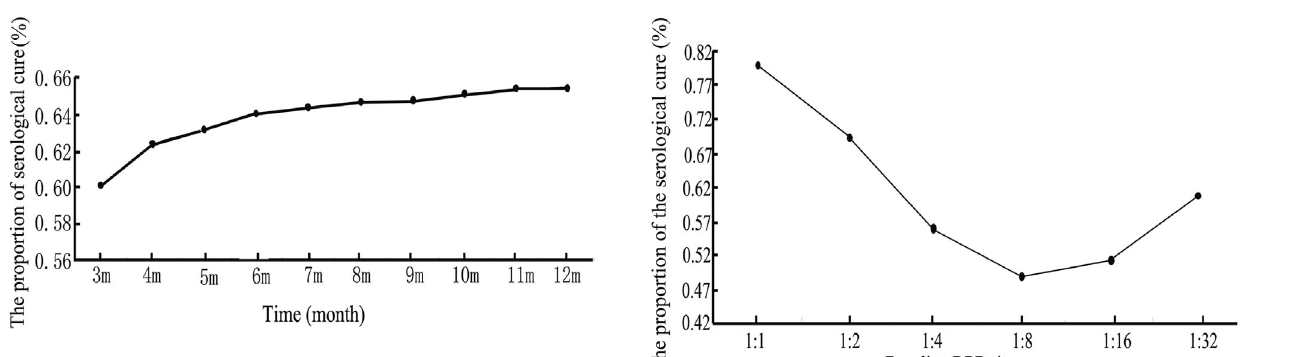
Figure 2. The proportion of the serological cure over time from 3 to 12 months. * Over the first year after therapy, the serological cure rate increased over the first 6 months; for 6–12 months after treatment, the serological cure rate exhibited only a slight increase, and there were no significant differences in the serological cure rate from 6 to 12 months ( X 2 =0.724, P =0.868).